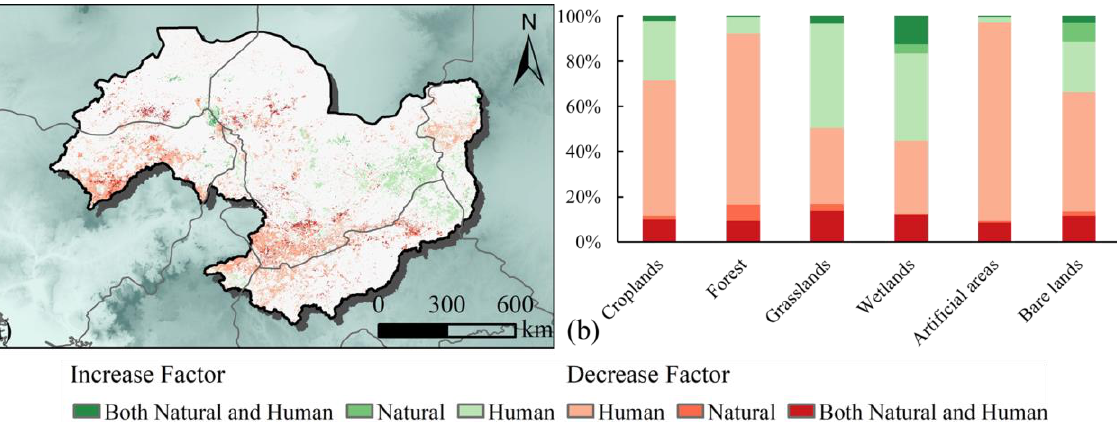
Figure 6. Driving factors of NPP in the CLCB. ( a ) Spatial distribution of driving factors of NPP, including increase factors and decrease factors; ( b ) Proportion of different factors of each terrestrial ecosystem.